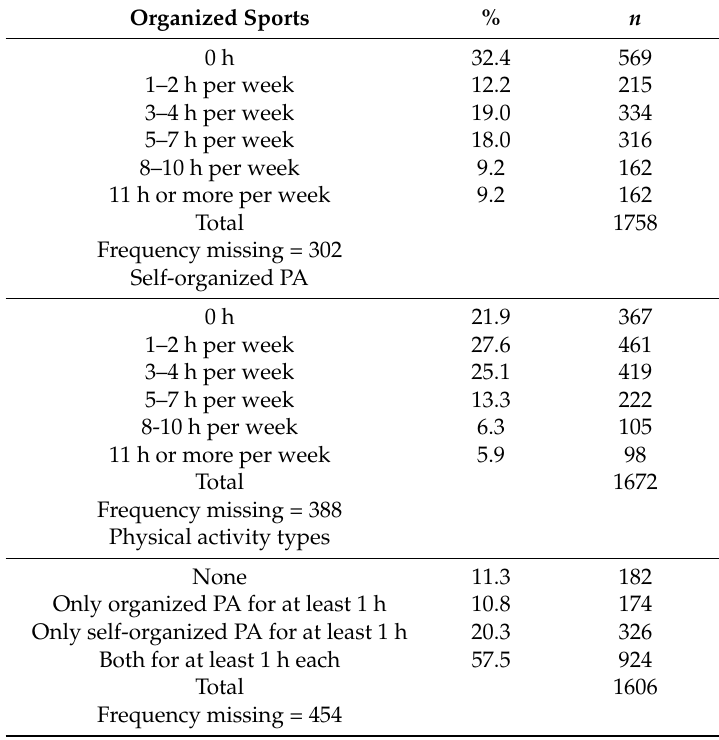
Table 1. Frequency distribution of number of hours spent in organized sports and self-organized physical activity